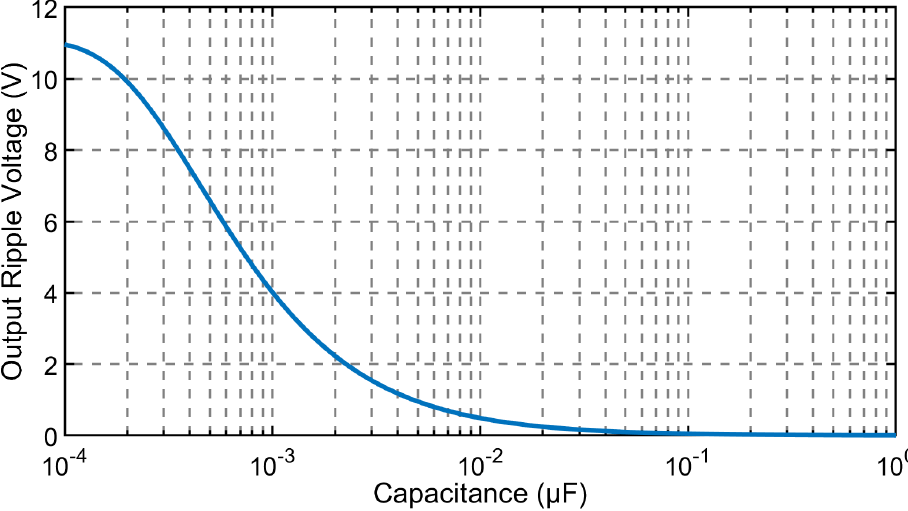
Figure 7. Output ripple voltages at different capacitances of the output